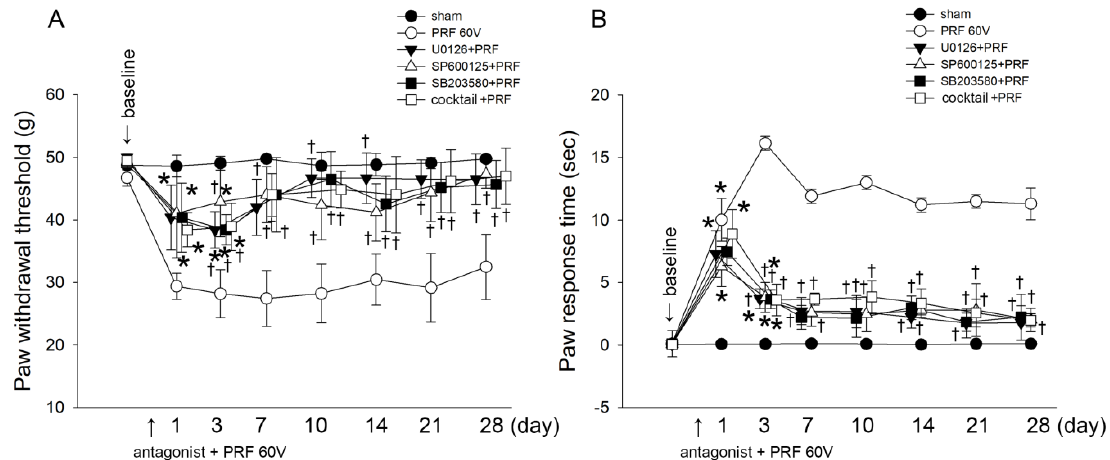
Figure 5. Comparison of the effects of MAPK antagonists on the paw withdrawal threshold and response time in the mechanical and cold allodynia tests. ( A ) Behavioral response and ( B ) paw response time in rats subjected to p38 MAPK antagonist (SB203580) plus PRF-60 volts ( ■ ), ERK1/2 antagonist (U0126) plus PRF-60 volts ( ▼ ), JNK/SAPK antagonist (SP600125) plus PRF-60 volts ( △ ), antagonist cocktail (SB203580 + U0126 + SP600125) plus PRF-60 volts (□), sham operation